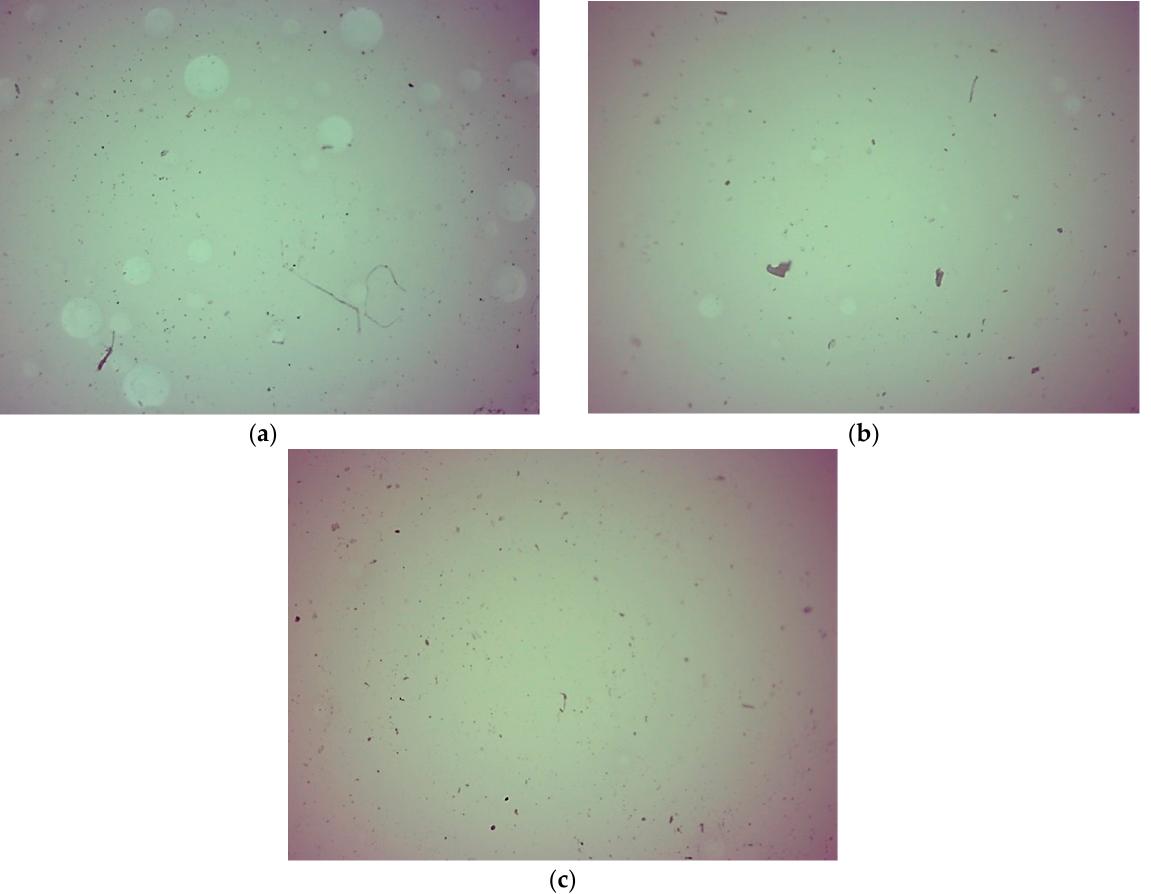
Figure 13. Optical images of hydrogels obtained using PEGDA 700: ( a ) 1.5 mL, ( b ) 2.0 mL, and ( c ) 2.5 mL (magnification 40×).